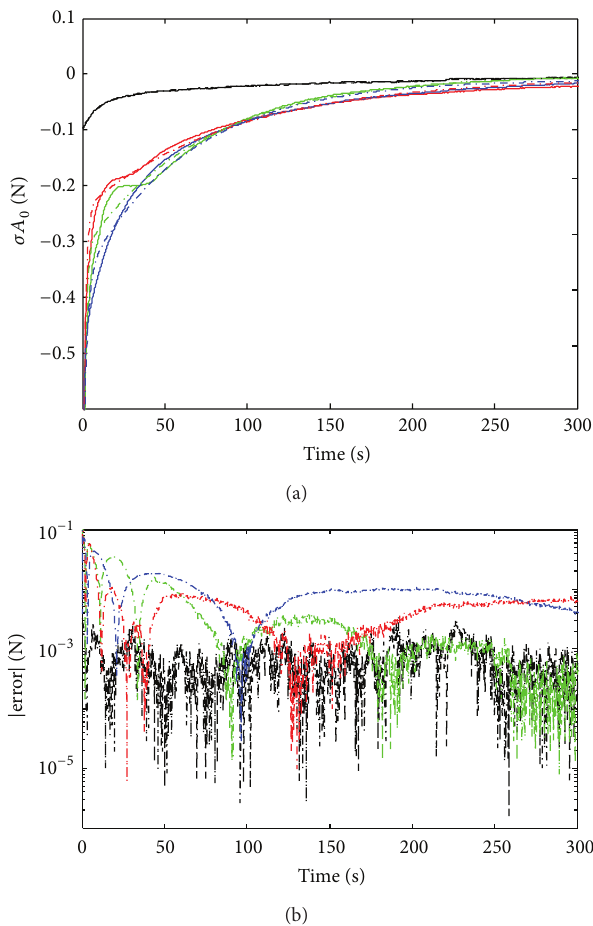
Figure 3: Relaxation tests. (a) Load relaxation in continuous black line corresponds to strain step of 25%. Red, green, and blue continuous lines are the measured relaxations using a step strain of 50%. Both strains are also applied to the estimated models and the values are plotted in dashed-dotted lines with the same color code. (b) shows the time evolution of the absolute error between the experimental curves and models fitting curves in logarithmic scale.